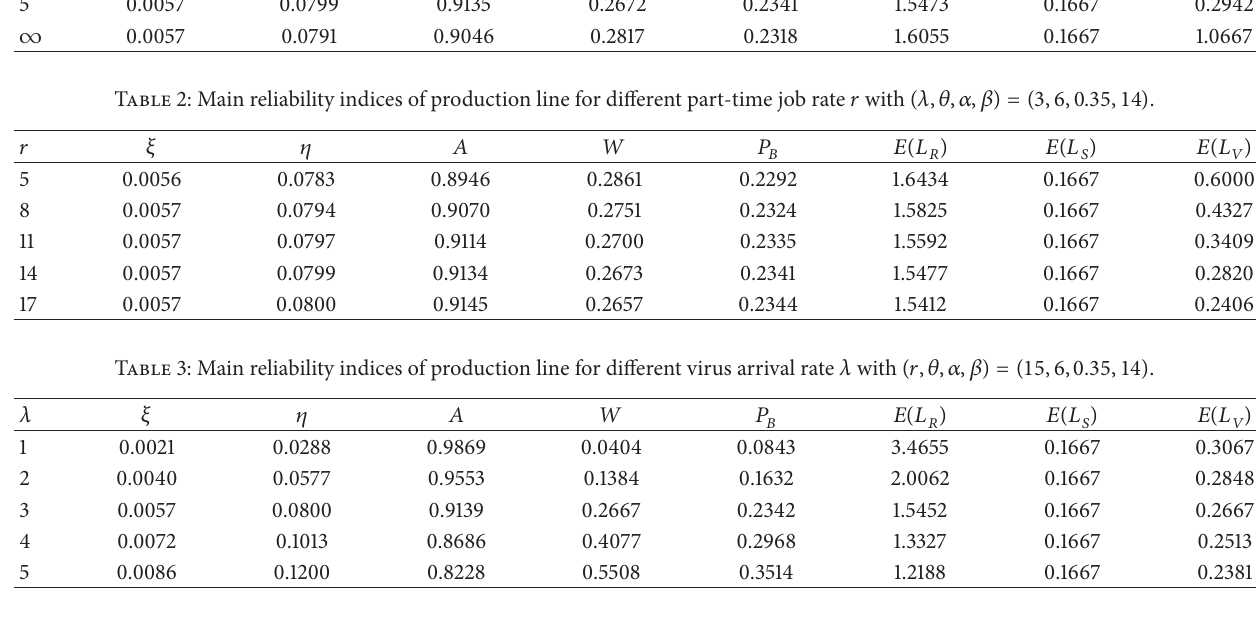
Table 4: Main reliability indices of production line for different startup time parameter 𝜃 with (𝜆,𝑟, 𝛼, 𝛽) = (3,15, 0.35, 14) .